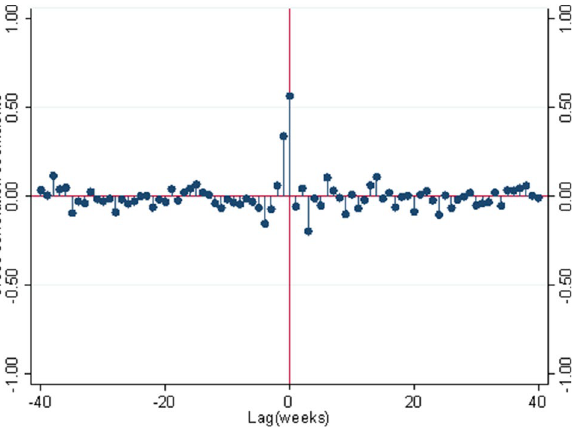
Figure 4. Cross-correlation between the KCDC sentinel ILI rates and National Health Insurance claims ILI rates.